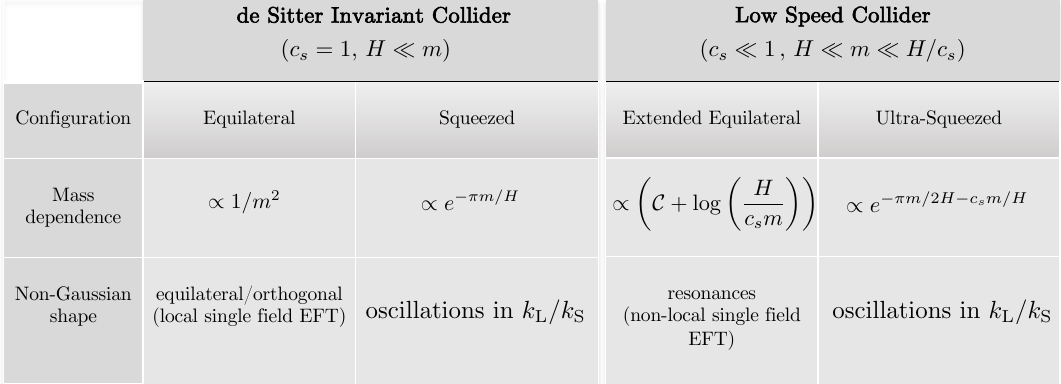
Figure 1 . In this table, we compare the qualitative properties of the imprints of heavy fields on the bispectrum between the two setups of the de Sitter invariant (more generally c colliders. In the low speed collider signal, the massive field propagates faster than the curvature perturbation and its generic sound speed c We highlight that the mass dependence of the low speed collider signal depends on the precise kinematical configuration in the extended equilateral region O (1) c one corresponding to the equilateral